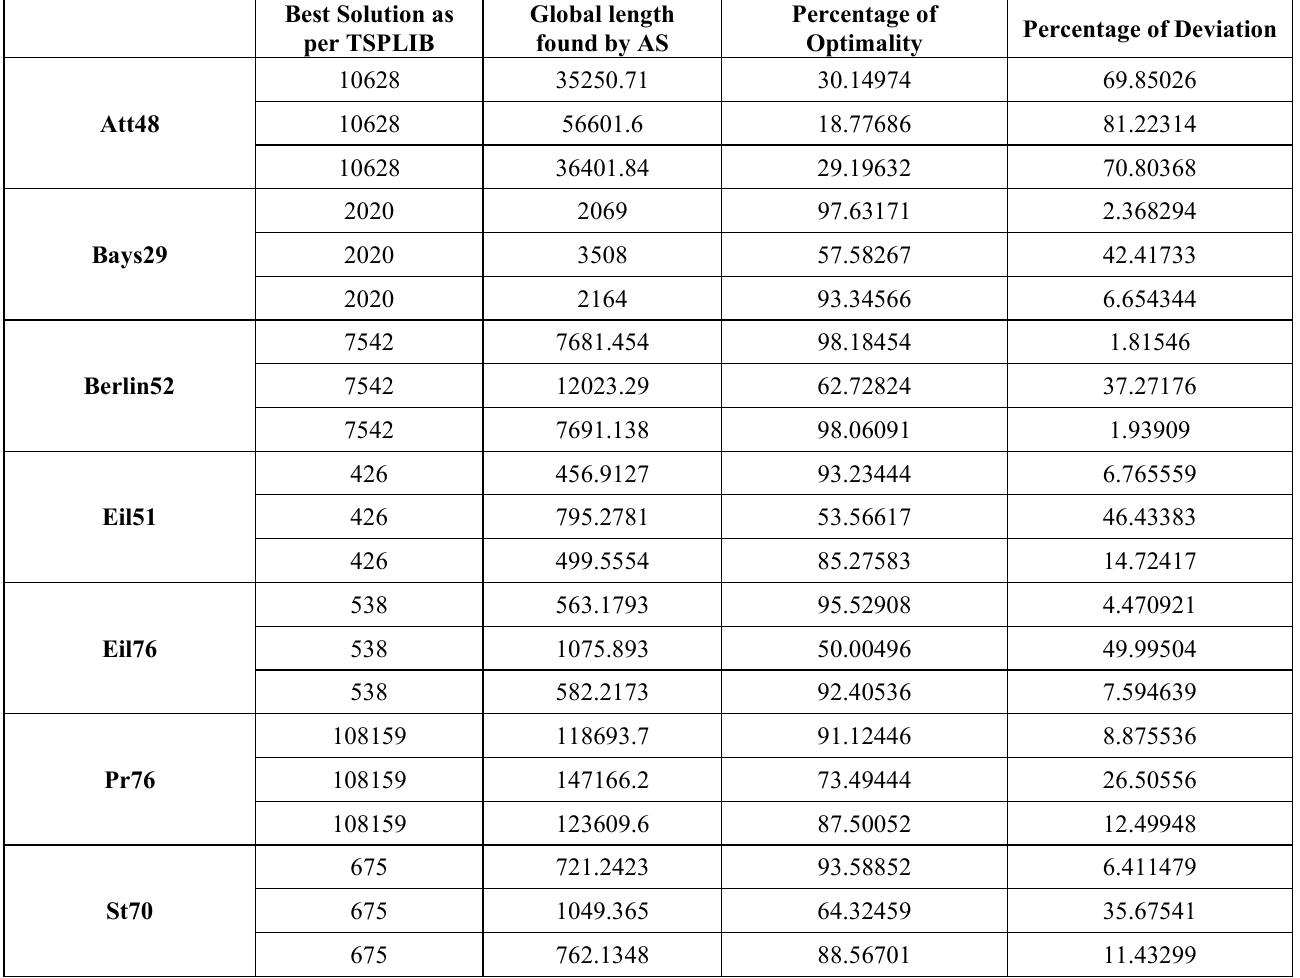
Table 3. Calculation of Percentage of Optimality and Deviation for AS Best Solution as Global length per TSPLIB found by